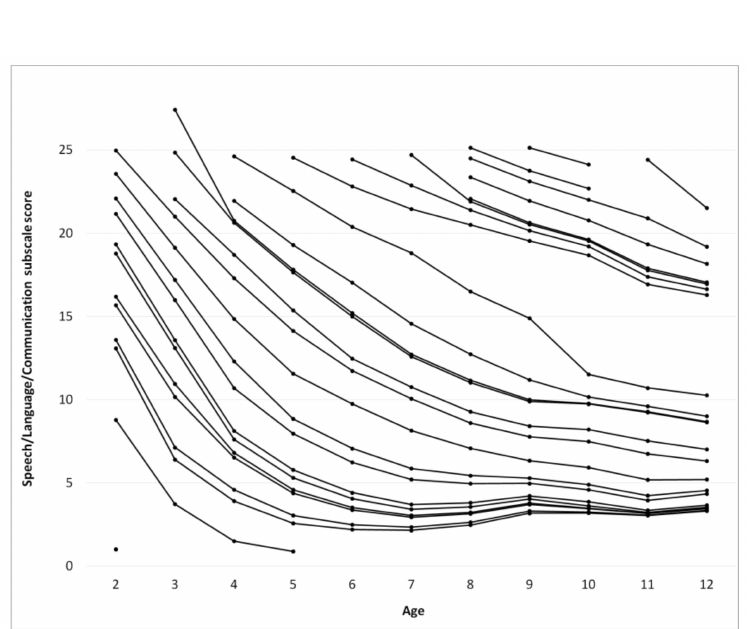
Figure 3. Continuous changes of the Speech/Language/Communication subscale score over age calculated from pair-wise observations using the “relay”